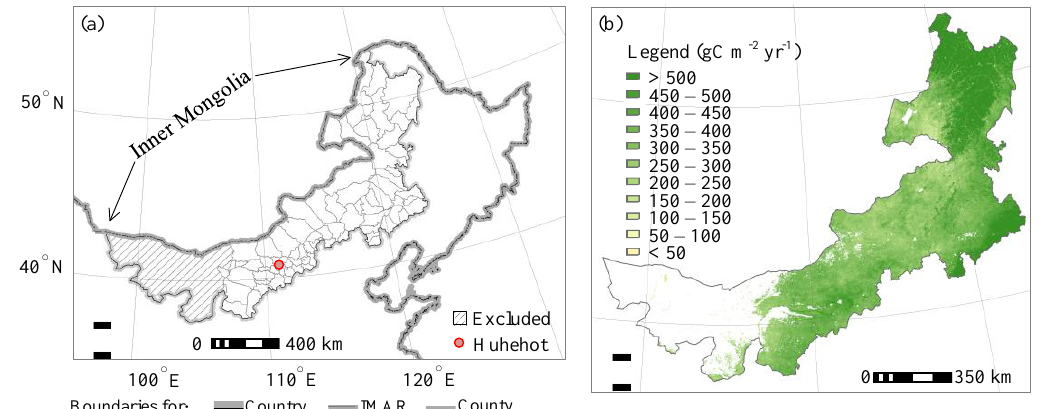
Figure 1. Study area. Some administrative units (counties) in the west mainly covered by desert or sandy areas or having very small vegetated area were excluded in the study. ( a ) Study area (Inner Mongolia) with administrative boundaries at the county level, and ( b ) Averaged NPP during 2001–2018.